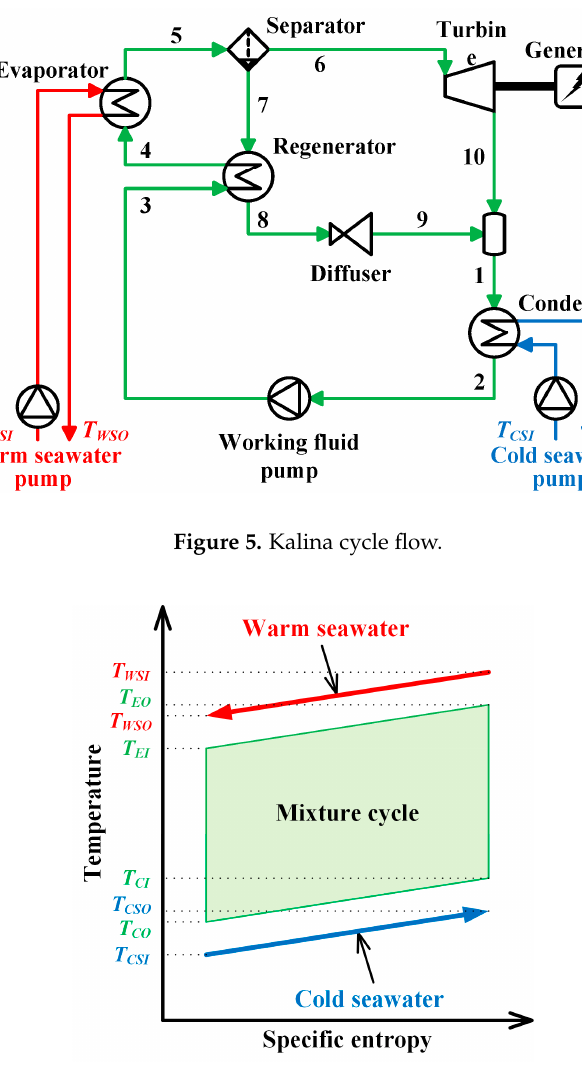
Figure 6. Conceptual T-s diagram of Kalina cycle.